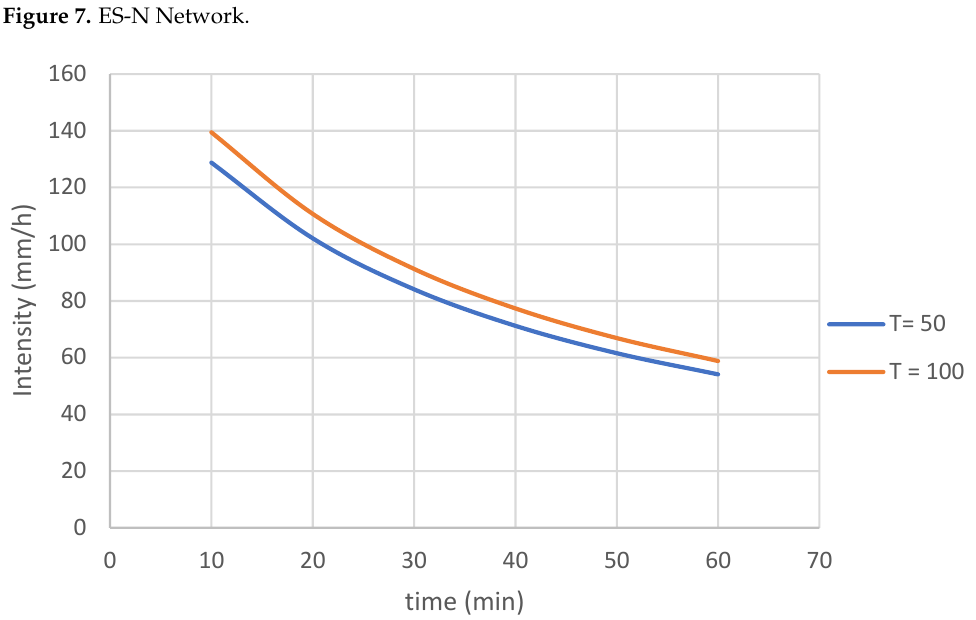
Figure 8. IDF curves studied for ES-N network.